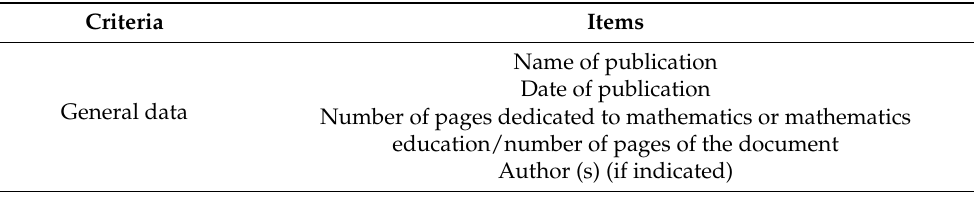
Table 1. Form for the analysis of mathematical and mathematics education